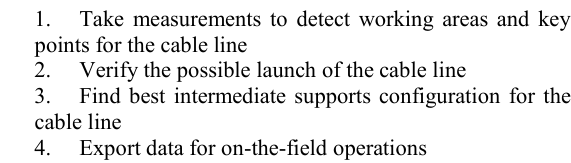
status (Figure 10). The different status colours corresponding to: none, measured, marked, field marked and processed, identify the current state of the tree and give a short history of the production process: starting from the initial measurement activity, passing through the virtual and real marking to the final cutting and processing tasks.